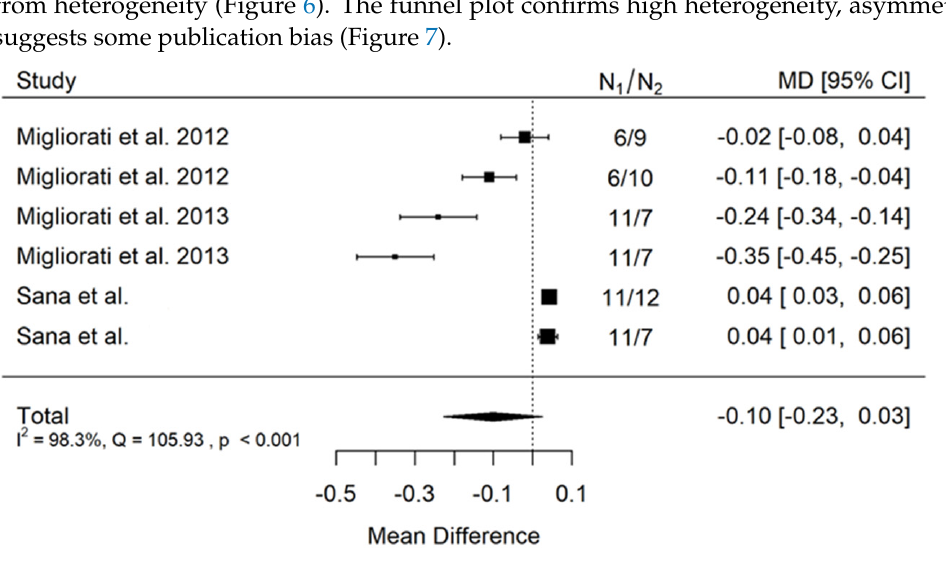
Figure 5. Funnel plot for evalutaion of thread pitch dimension infulence on pull-out strentght in animal bone model studies.